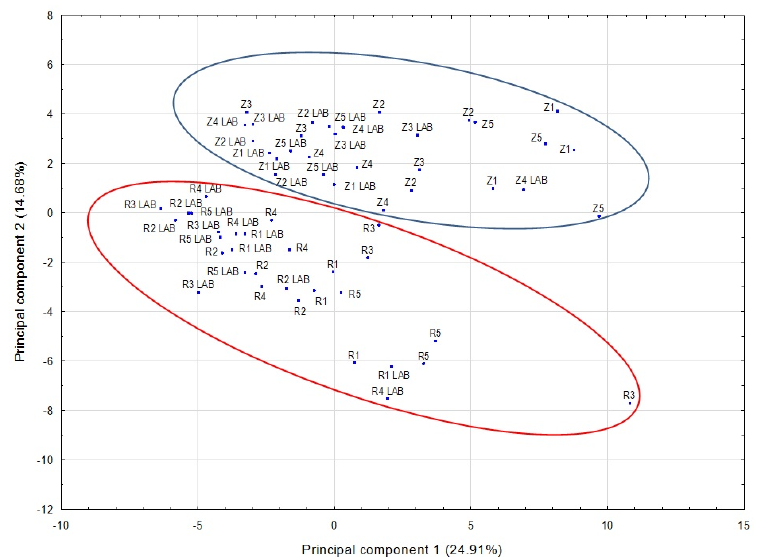
Figure 3. Score plot on the PCA plane defined by the first two principal components for all volatile compounds found in the wine samples. Z1–Z5—Zweigelt wines in which AF was induced using various yeast strains and MLF was spontaneous. Z1 LAB–Z5 LAB—Zweigelt wines in which AF was induced using various yeast strains (the same strains as in Z1–Z5 wines) and MLF was carried out by inoculation with lactic acid bacteria. R1–R5—Rondo wines in which AF was induced using various yeast strains and MLF was spontaneous. R1 LAB–R5 LAB—Rondo wines in which AF was induced using various yeast strains (the same strains as in R1–R5 wines) and MLF was carried out by inoculation with lactic acid